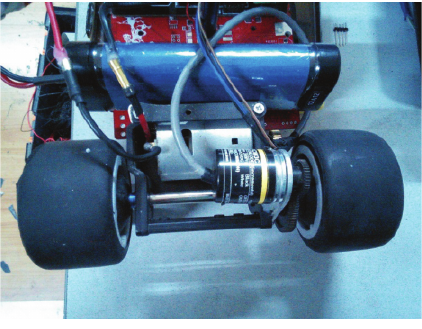
Figure 1: Model of smart car.